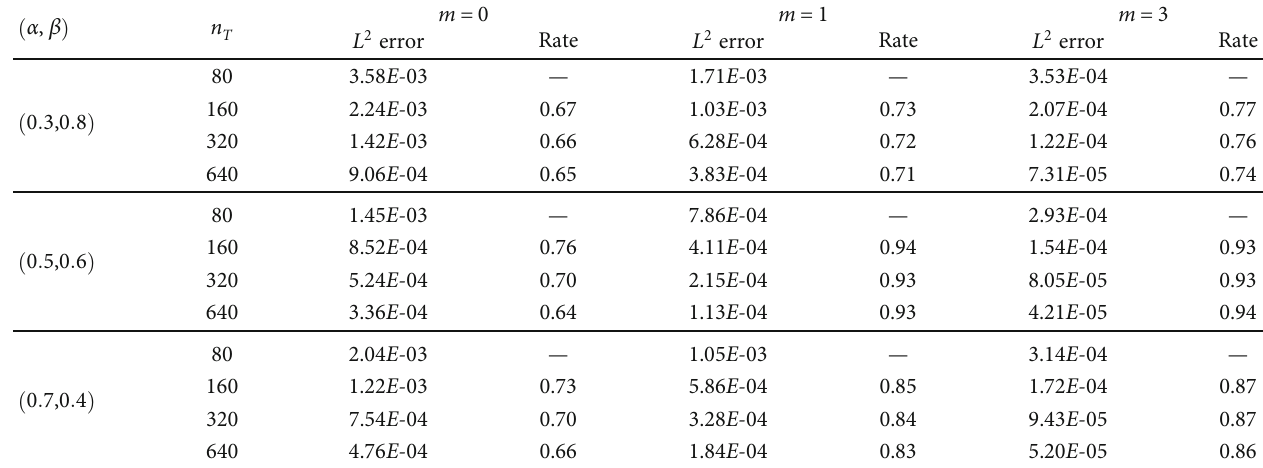
Table 1: The L 2 -norm errors in time for nonsmooth case in Example 1 with h = 1/64